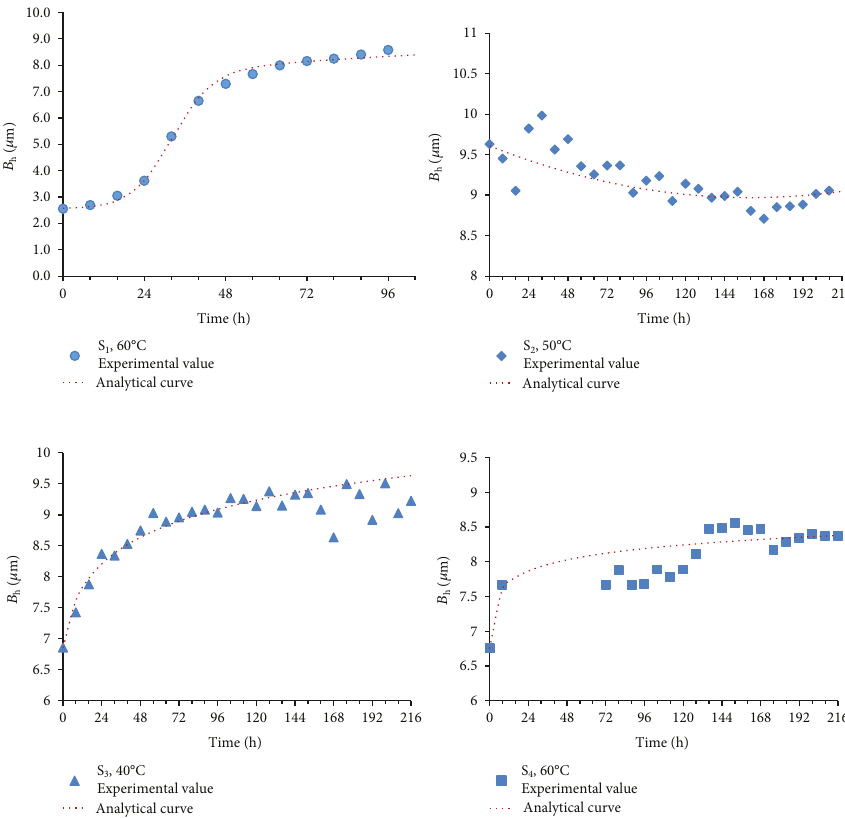
Figure 8: Hydraulic apertures of the fractures over time during the CFDE experiments.